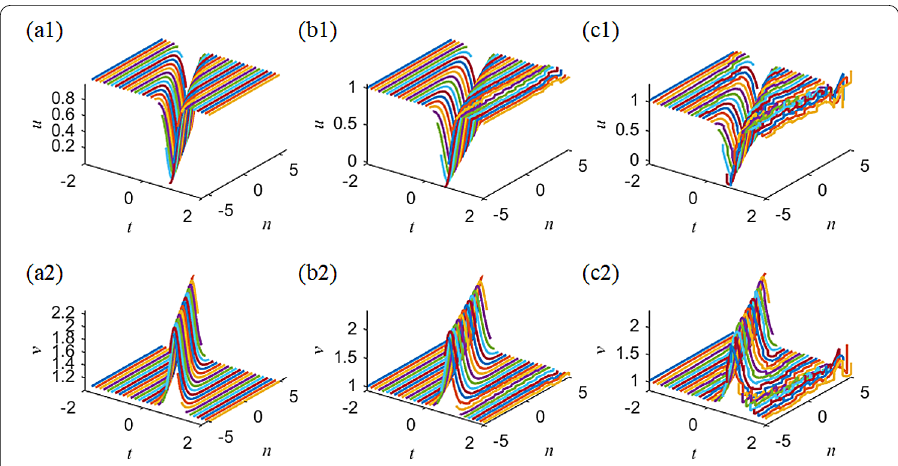
Figure 9 Exact one-soliton solutions (cid:8) u n and (cid:8) v n in (50) with N = 1 via the parameters r 1 = –1, r 2 = 1, λ 1 = –1, λ 2 = –2. ( a ) Exact solution; ( b ) Time evolution using exact solution as an initial condition; ( c ) Time evolution using exact solution perturbed by a 2% noise as the initial condition